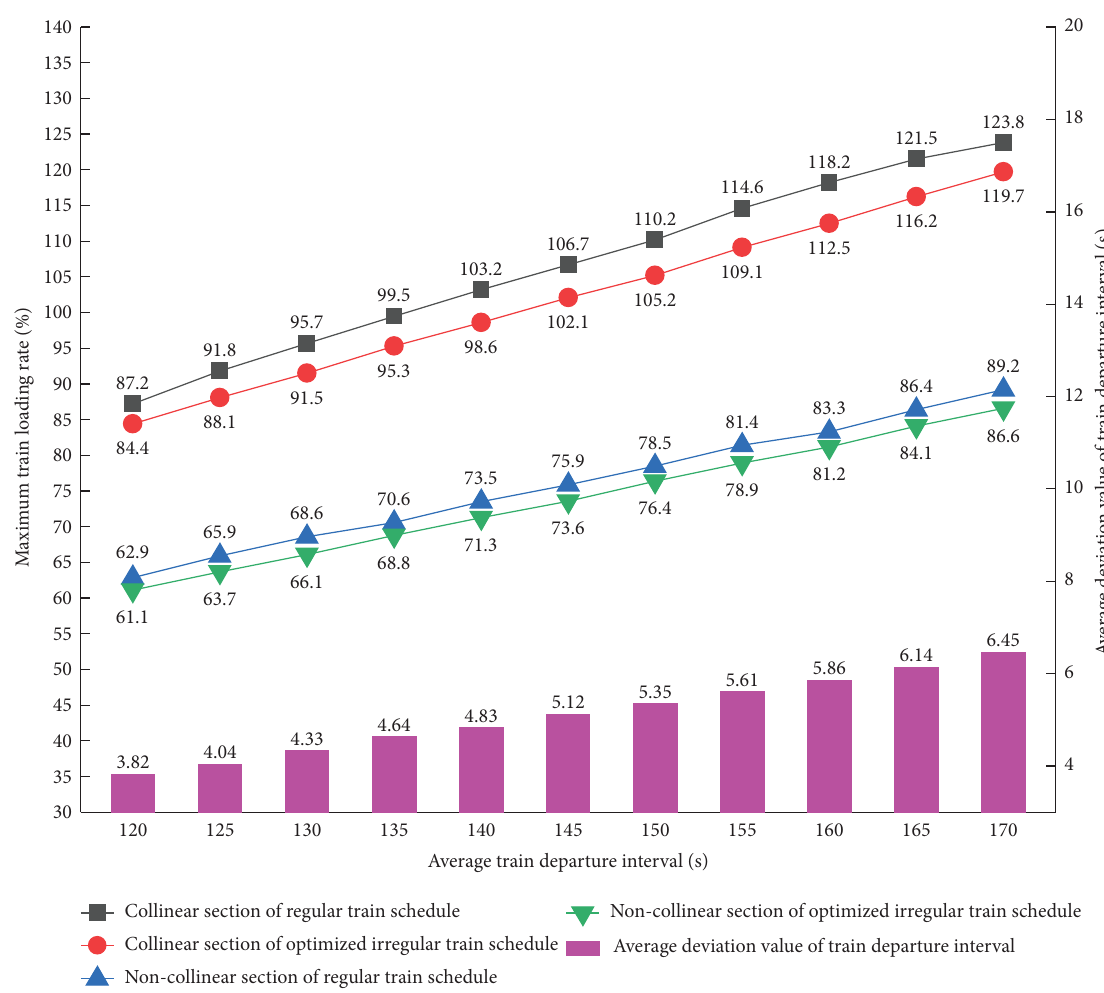
Figure 7: Comparison of results between an optimized irregular schedule and a regular